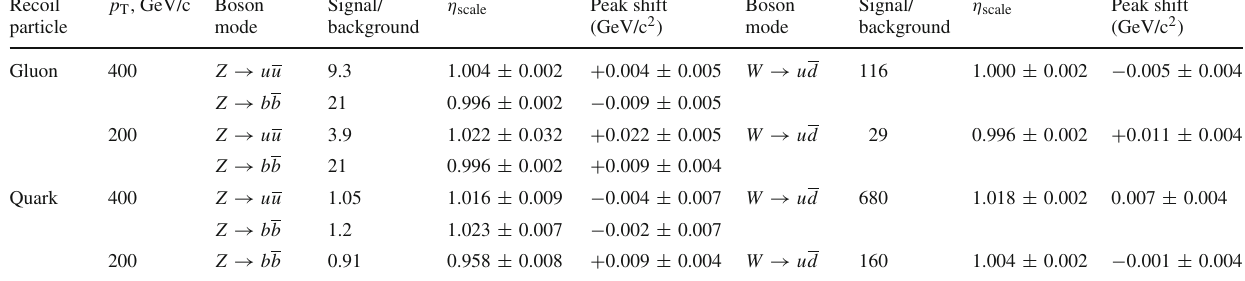
out experimental resolution and using only the initial and final states quoted, with negligible statistical error